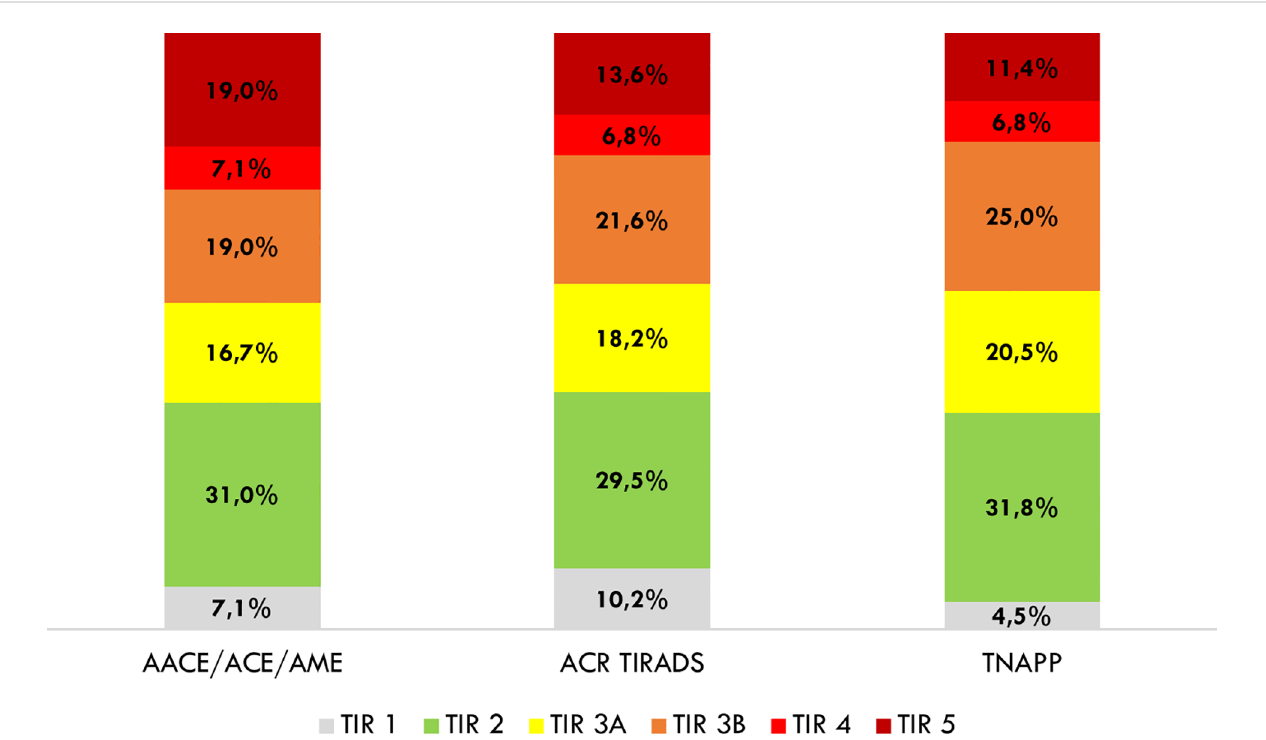
FIGURE 4 Distribution of avoidable thyroid biopsies after a retrospective analysis of cytological fi ndings. AACE/ACE/AME, American Association of Clinical Endocrinology/American College of Endocrinology/Associazione Medici Endocrinologi; ACR TI-RADS, American College of Radiology Thyroid Imaging Reporting and Data System; TNAPP, Thyroid Nodule App.